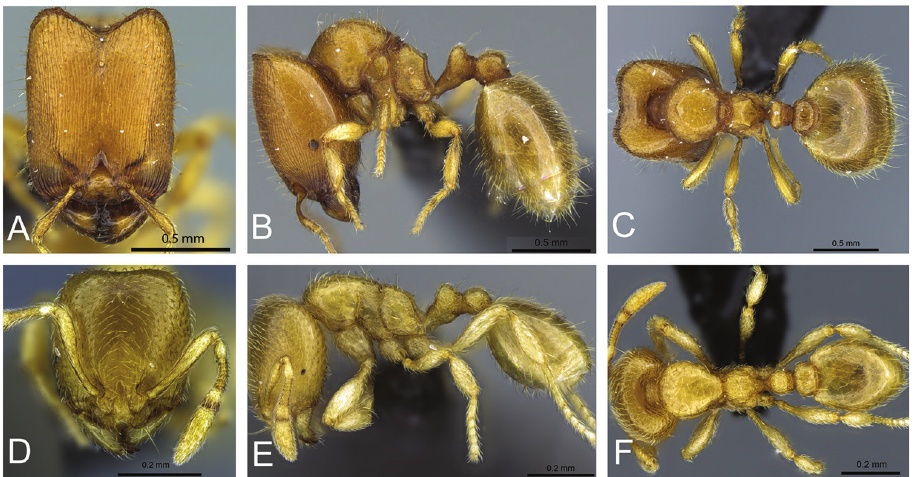
Figure 66. Carebara vazimba –holotype. Major worker, CASENT0055532: A head in full-face view B body in profile view C body in dorsal view. Minor worker, CASENT0055533: D head in full-face view E body in profile view F body in dorsal